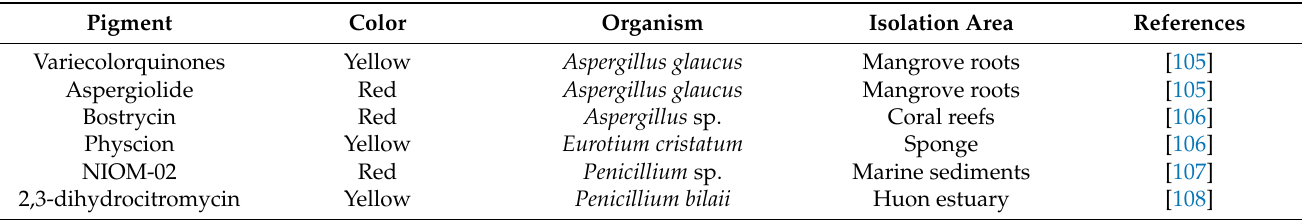
Table 2. Some biopigments of microbial origin isolated from new ecological niches. Pigment